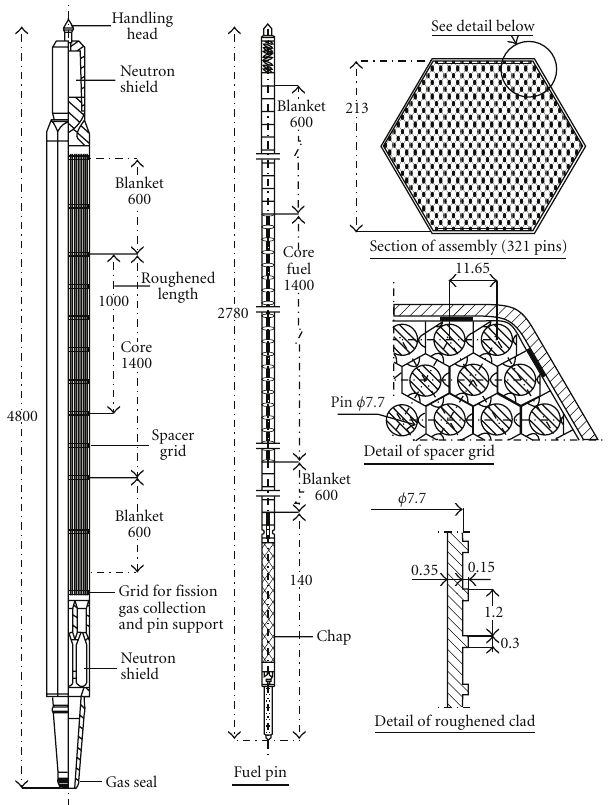
Figure 5: Overview of the GBR-4 fuel assembly. An example of roughened cladding is in the lower right figure.